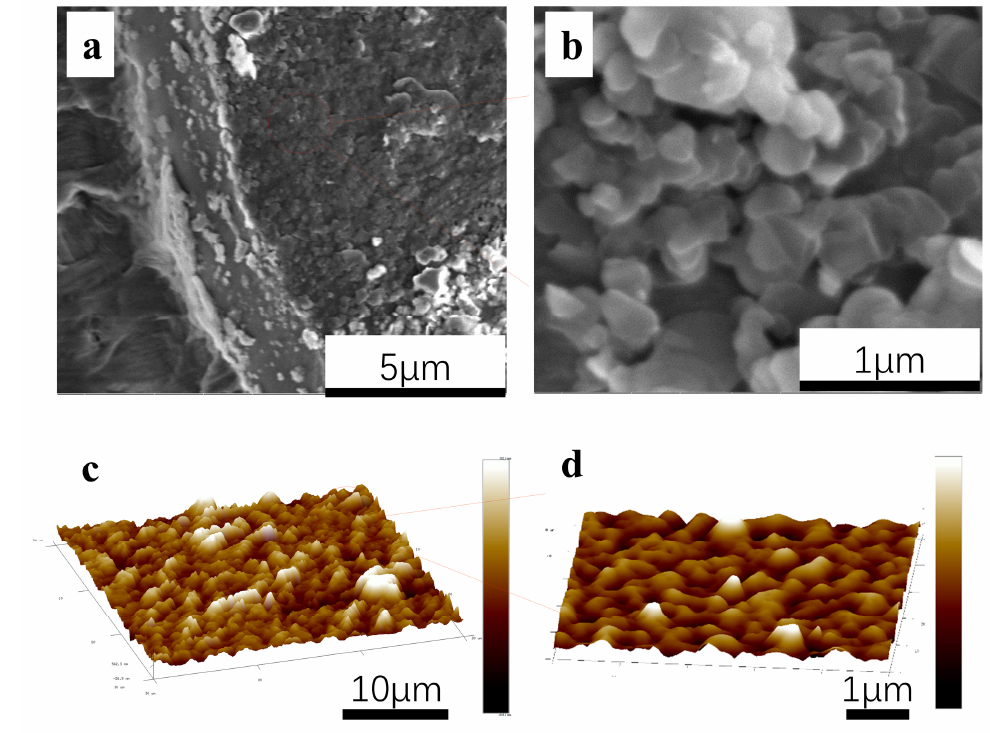
Figure 2. Microstructure of the single-layered PE/BNNPs film. ( a , b ) The in-plane FE-SEM image of stacked BNNPs on the surface of PE film; ( c , d ) AFM images at the centre of the single-layered PE/BNNPs